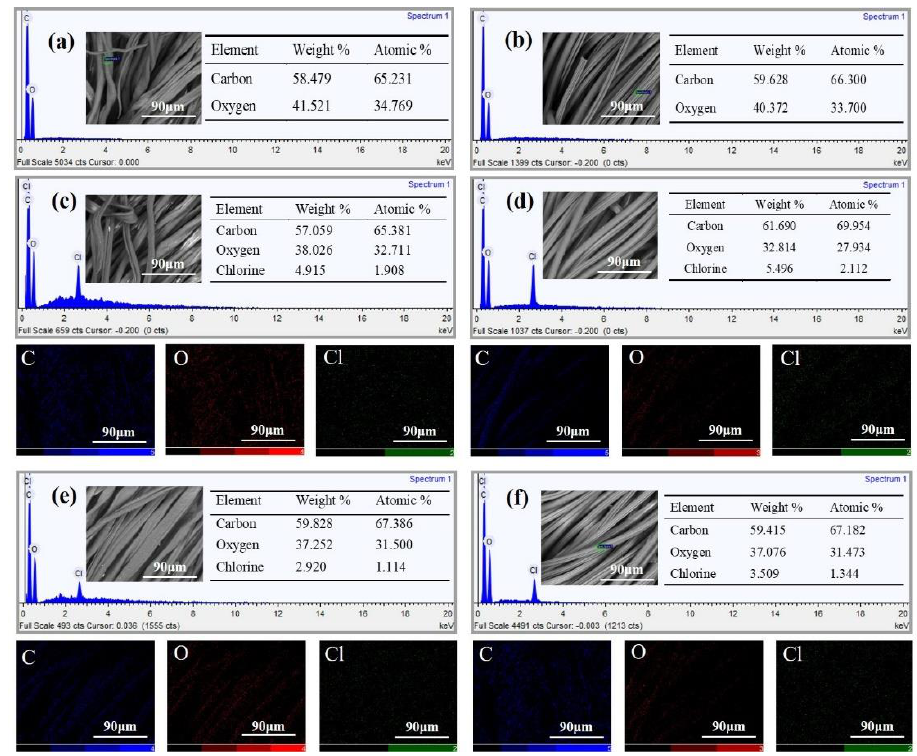
Figure 7. SEM images of original and treated fabrics. ( a – d ) original C, C/V, T/C and T/V fabrics; ( e – h ) treated C, C/V, T/C and T/V fabrics with the dipping process; ( i – l ) treated C, C/V, T/C and T/V fabrics with the pad–dry–cure process.